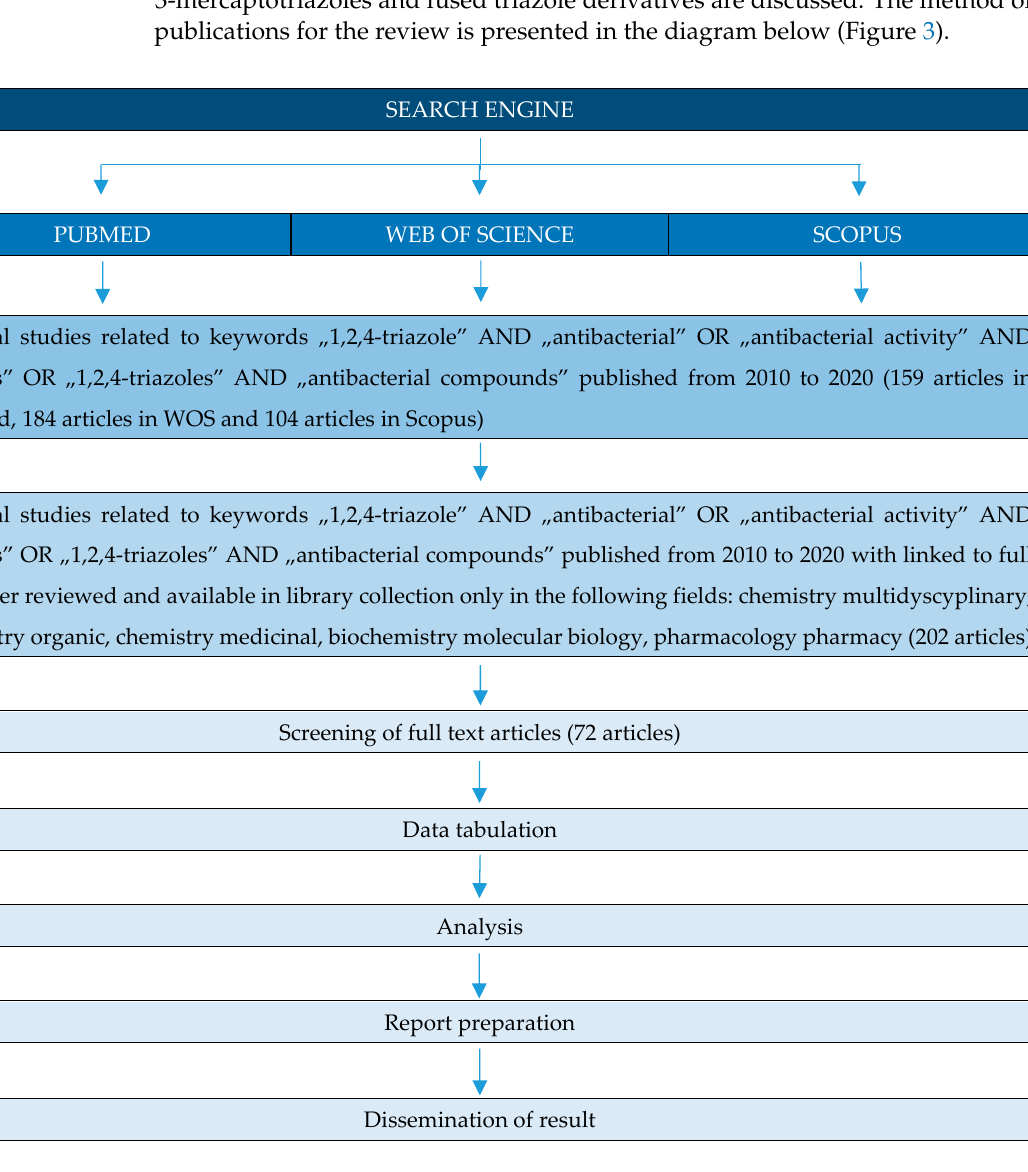
Figure 3. PRISMA flow diagram of the identification of literature for inclusion in this review.